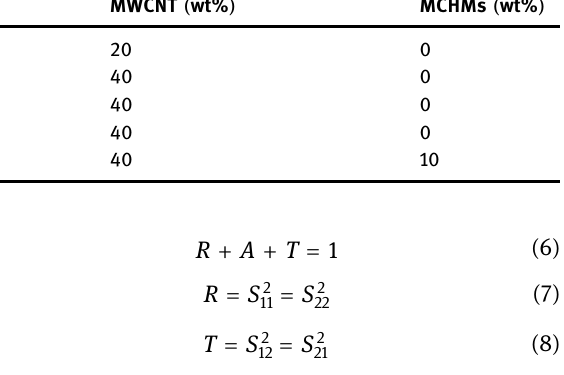
Table 1: Density of samples